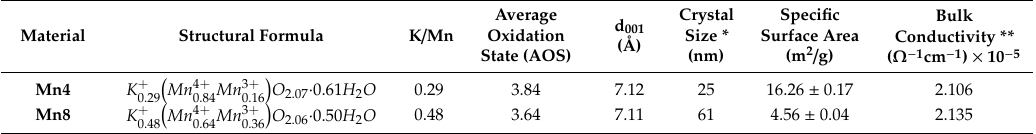
Table 1. Structural formulas for birnessite-type materials.